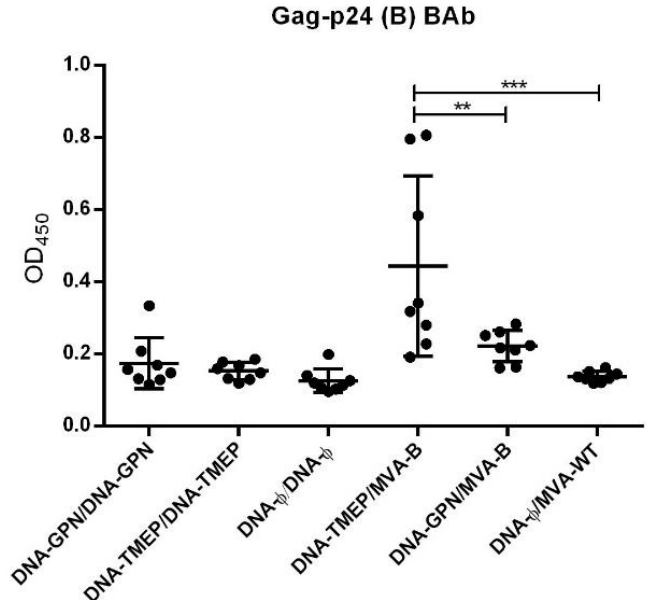
Figure 6. Anti-p24 humoral responses elicited in serum from immunized mice after prime/boost immunization with TMEP-B construct and MVA-B virus. The graph represents the values of optical density at 450 nm (OD 450 ) for each animal at a serum dilution of 1:50 (dots) and the mean value (solid line) and standard deviation of each group. ** p < 0.005; *** p < 0.001.